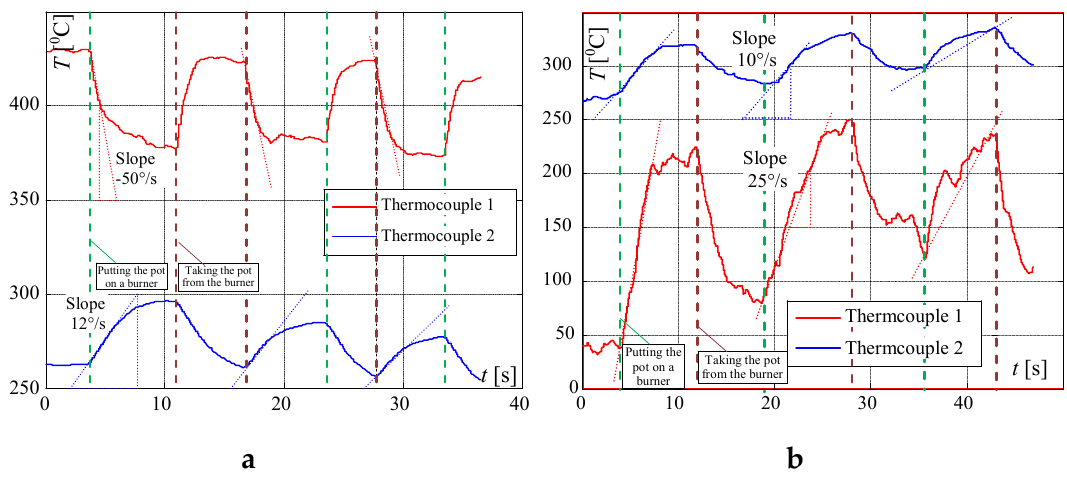
Figure 5. Temperature changes measured by K-type thermocouples while operating the valve (opening and closing): ( a ) without a pot; ( b ) with a pot.